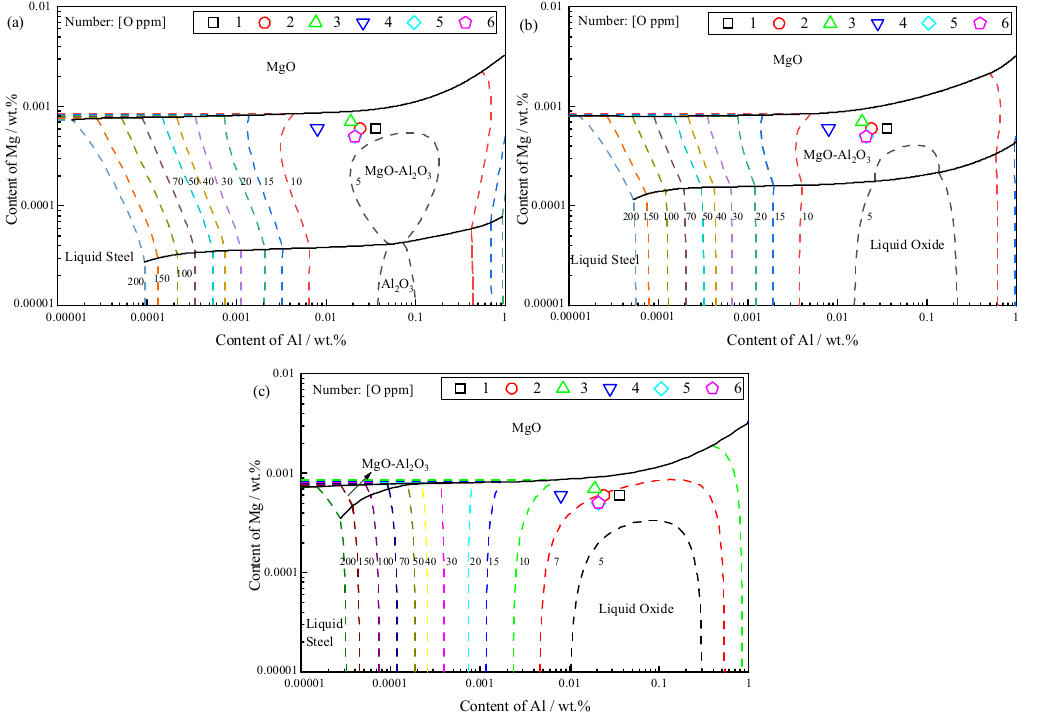
Figure 8. Effect of different calcium content on MgO-Al 2 O 3 inclusions: ( a ) no calcium; ( b ) 1 ppm [Ca]; ( c ) 3 ppm [Ca] (C: 0.4%-Cr: 0.98%-Mo: 0.16%).